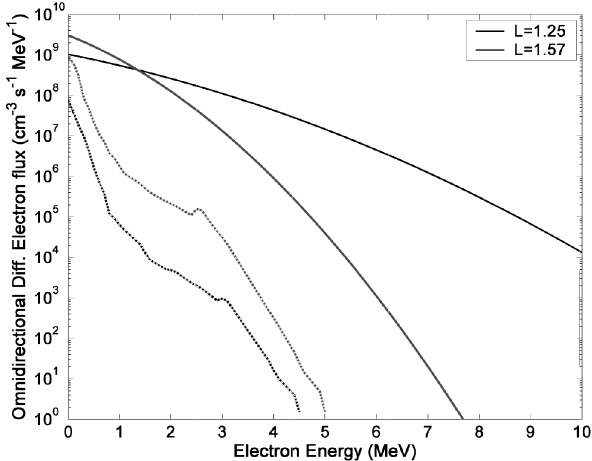
Fig. 2. The post-Starfish Prime HANE radiation belt environment in the inner radiation belt, showing the equatorial omnidirectional dif- ferential electron flux. Note the softening of the trapped equatorial electron spectrum from an equilibrium-fission spectrum (at L =1.25) with the expansion of the HANE produced bubble The dotted lines show the ambient trapped population from the ESA-SEE1